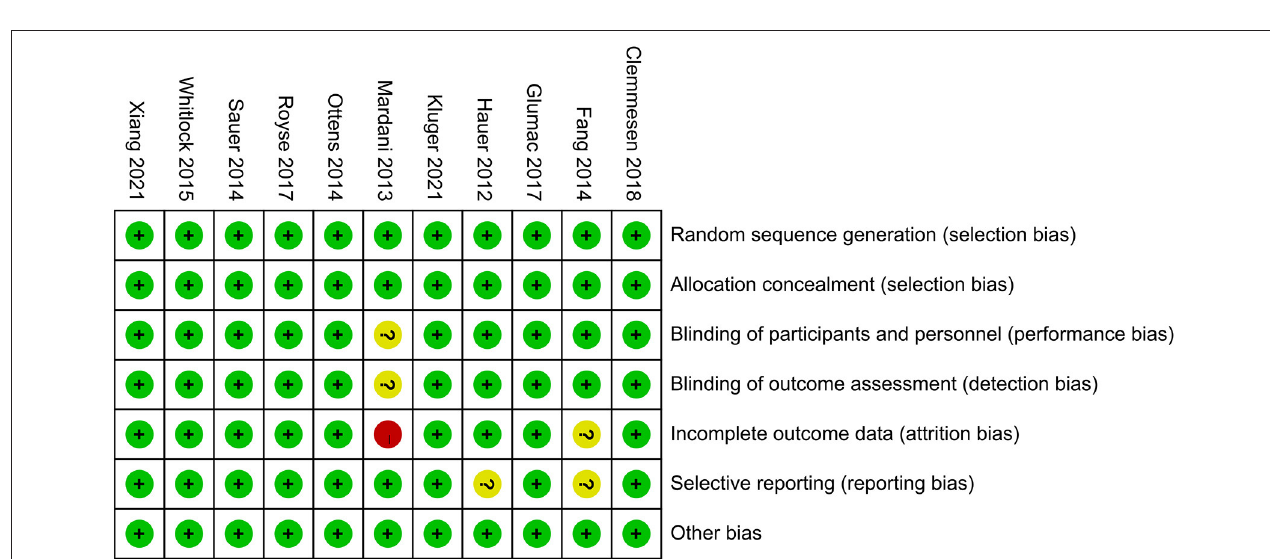
FIGURE 1 | Flow chart of search strategy to identify the eligible randomized controlled trials.